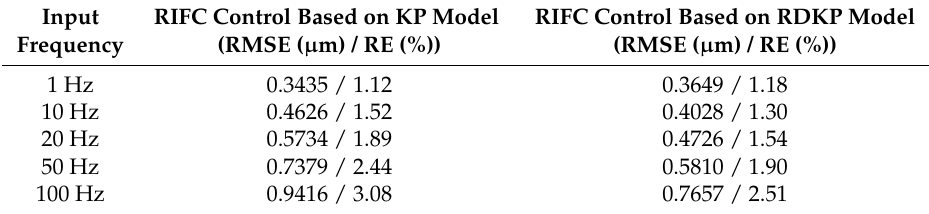
Table 2. Comparison of tracking errors between the classic KP model and the proposed RDKP model under sinusoidal trajectories with diverse input frequency based on the RIFC control method.